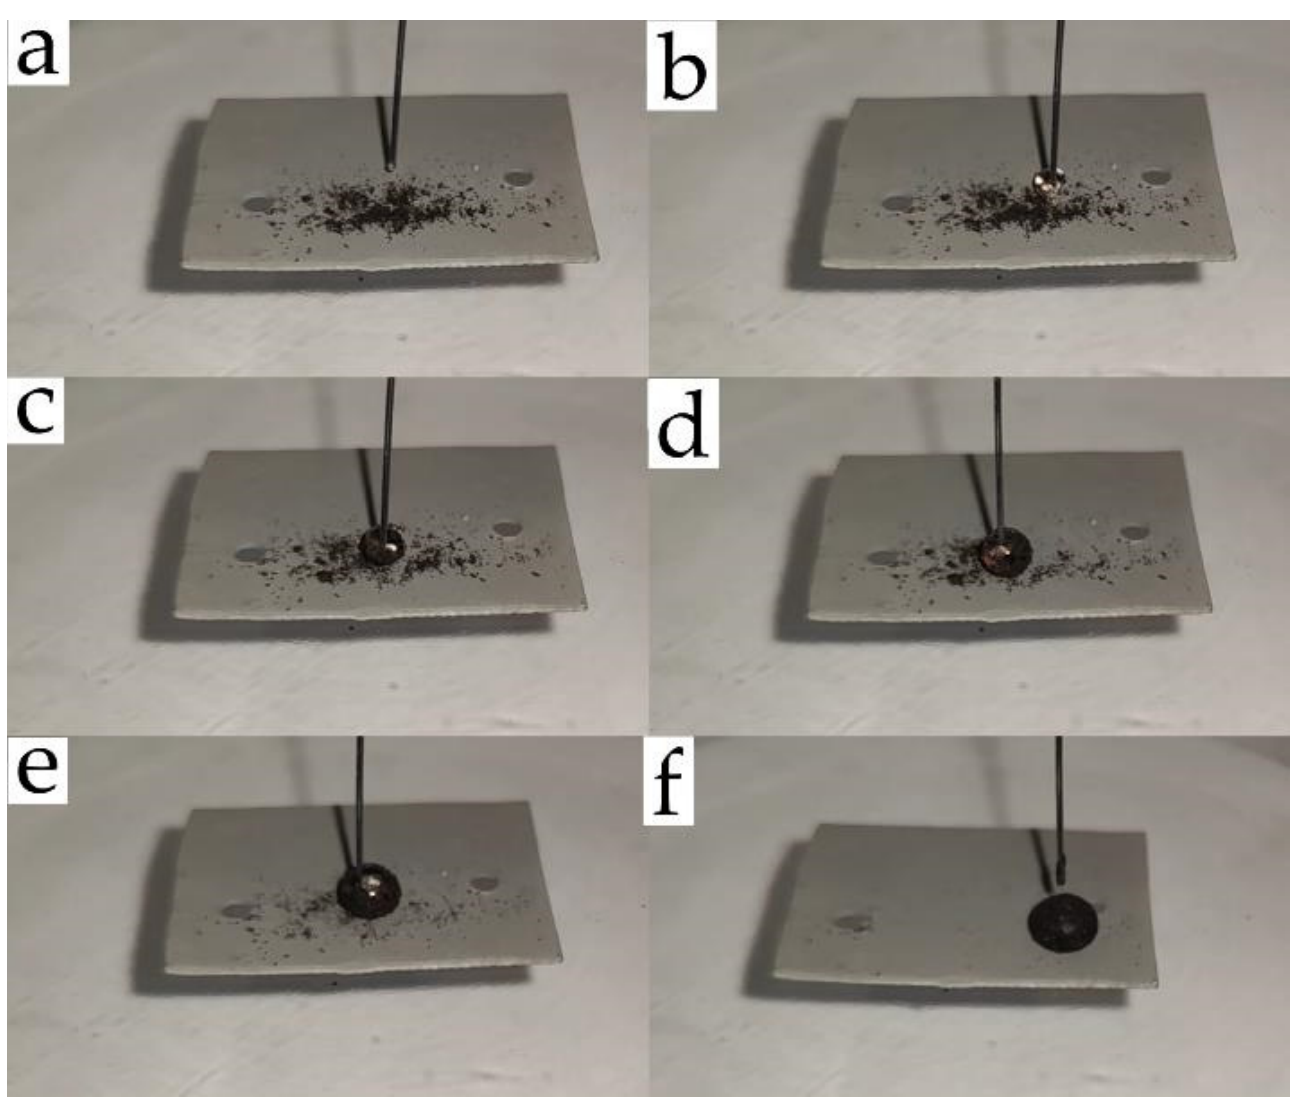
Figure 8. Demonstration of the self-cleaning effect as a result of the collection of soil particles from the superhydrophobic aluminum surface due to the movement of a water droplet across the sur- face: ( a ) 0; ( b ) 3; ( c ) 6; ( d ) 9; ( e ) 18; ( f ) 45 s. ( a ) 0; ( b ) 3; ( c ) 6; ( d ) 9; ( e ) 18; ( f ) 45